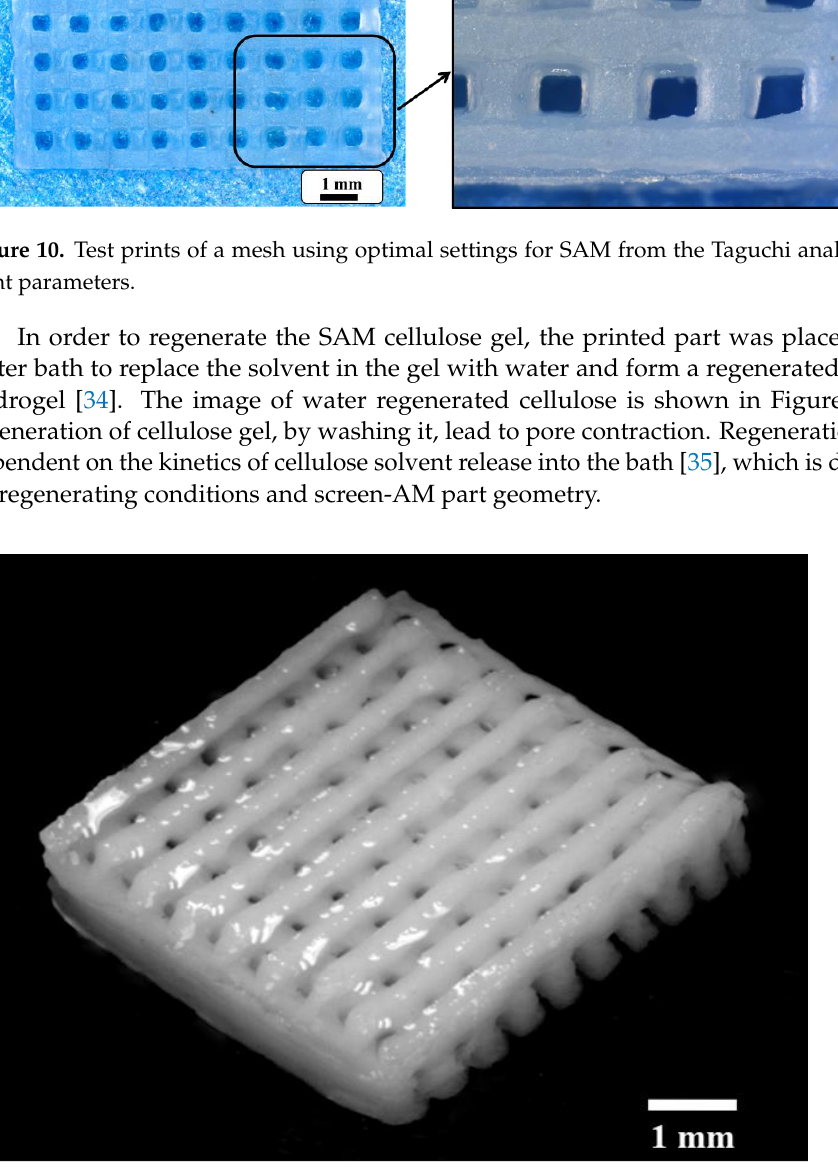
Figure 11. SAM a mesh structure using cellulose